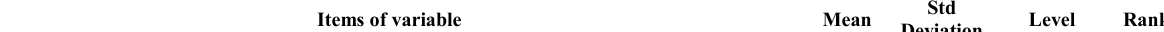
Table 3. Descriptive result for single use plastic reducing behavioral intention (dependent variable). Items of variable Level Rank